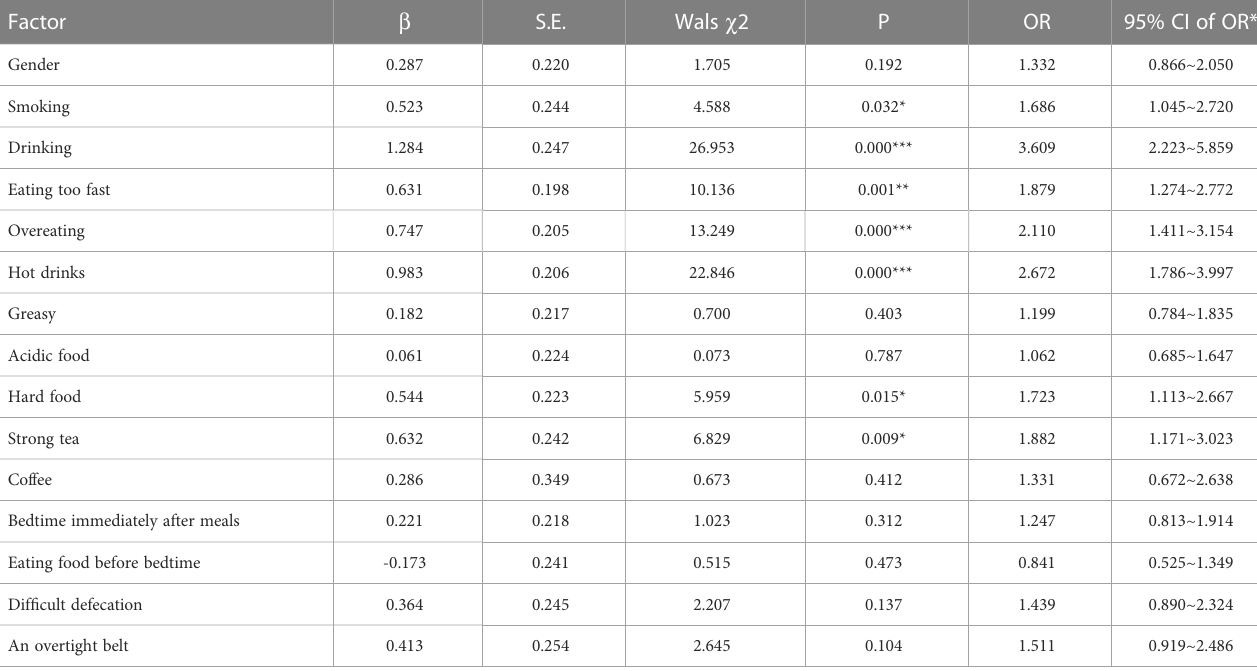
TABLE 3 Multivariate analysis of lifestyle risk factors for esophageal cancer. Factor